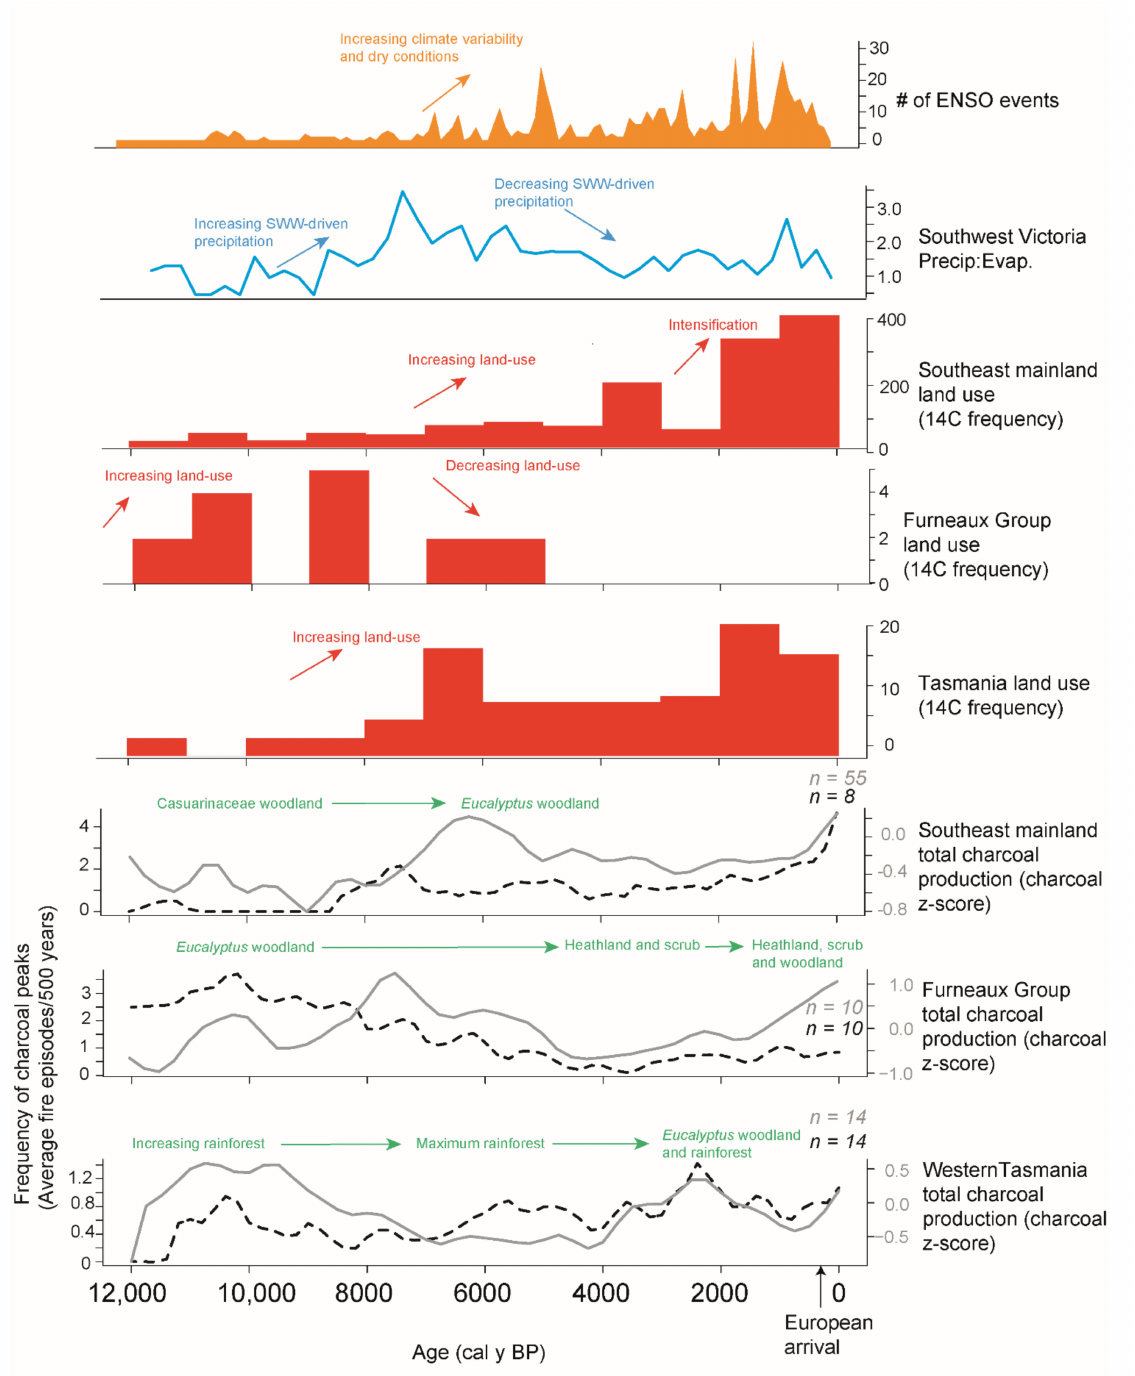
Figure 4. Regional biomass burned—charcoal z -score (solid grey line) and recurrence-rate-of-fire-episodes—average fire episodes/500 years (black dashed line) for the Furneaux Group islands (FGI), western Tasmania and the mainland in relation to vegetation, anthropogenic land use [23], SWW-driven changes in precipitation [67] and ENSO [66]. Vegetation labels are based on major palaeoecological interpretations in published studies from respective regions (e.g., [17–19,49,52,53,72,73]). Note the different scales of 14C dates (anthropogenic land